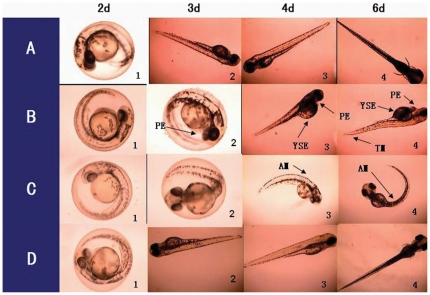
SEM images of Zebrafish embryos.Embryos exposed for 8 h in distilled water (A), 400 mg/L nano-TiO2 (B), 400 mg/L nano-SiO2 (C) and 400 mg/L nano-HA (D). The freeze-drying of embryos was carried out at −55°C for 12 h.